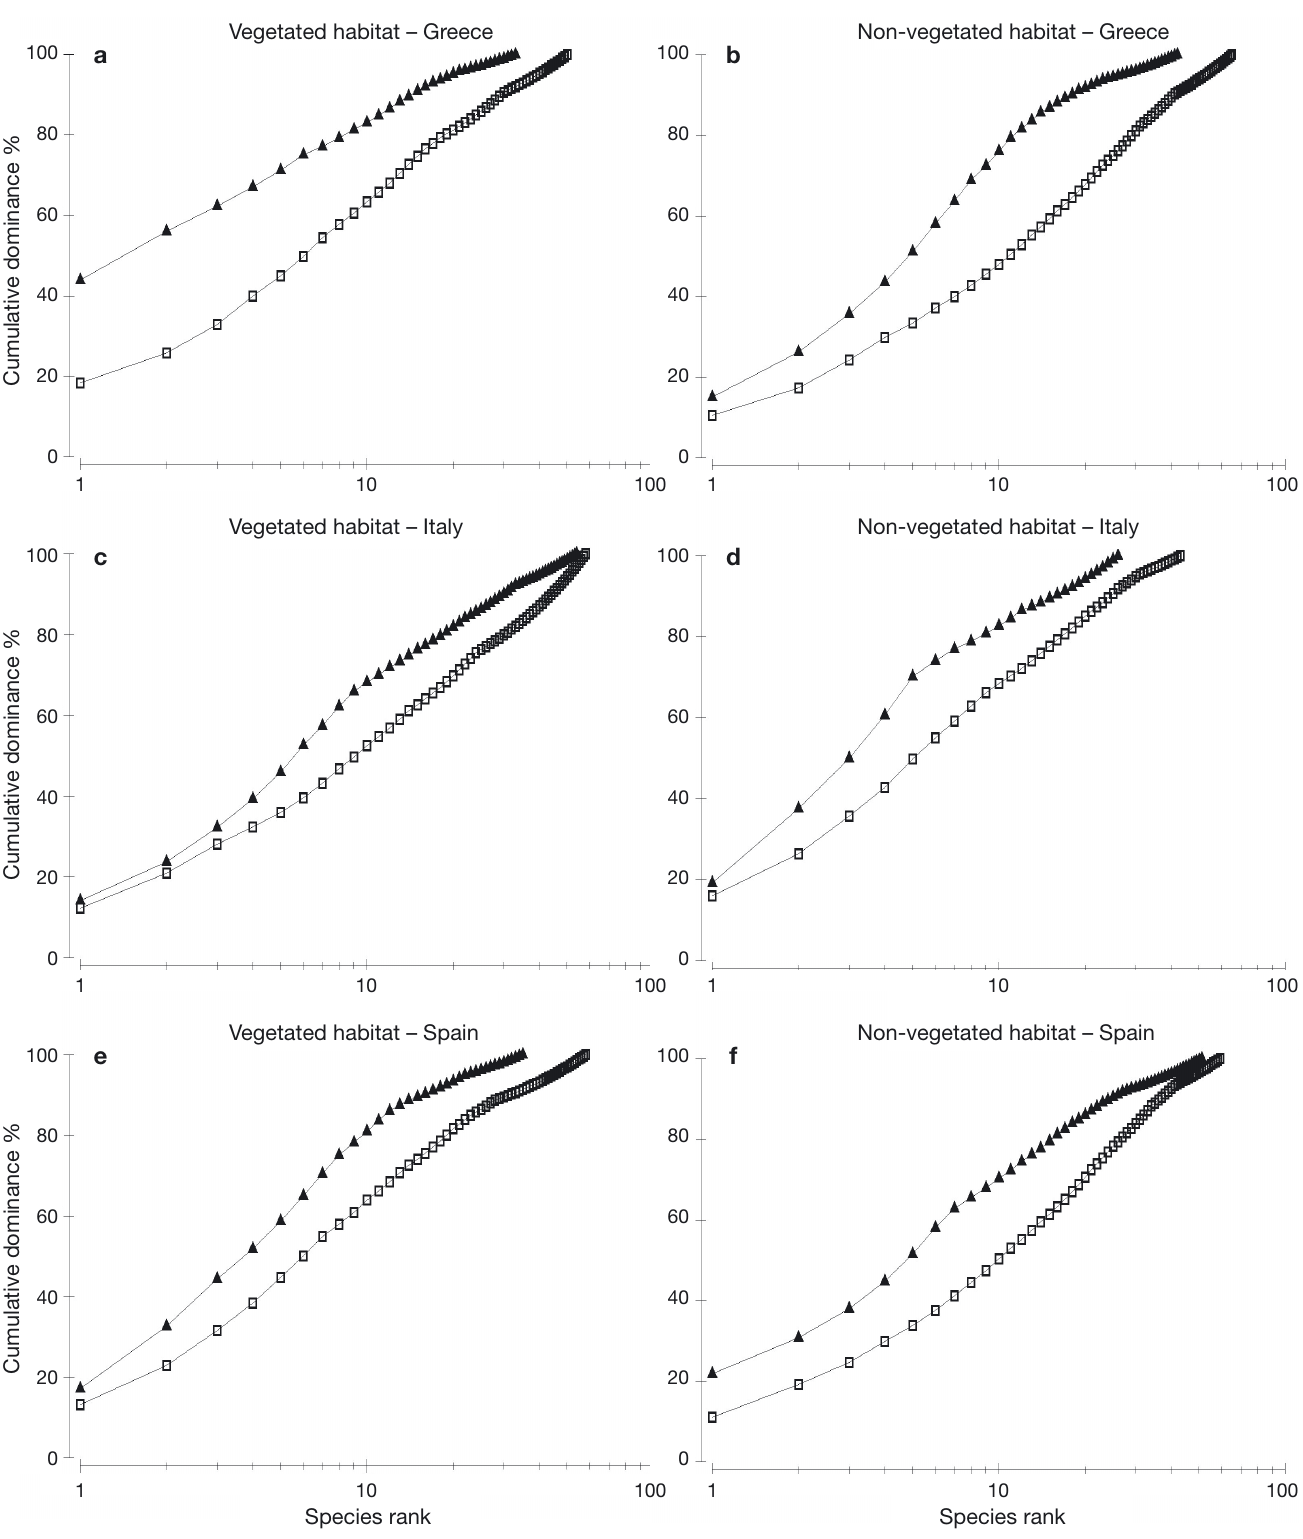
Fig. 3. K -dominance curves based on nematode species identified from the 3 investigated regions: (a) vegetated and (b) non- vegetated sediments in Greece, (c) vegetated and (d) non-vegetated sediments in Italy, and (e) vegetated and (f) non-vege- tated sediments in Spain. Each curve compares nematode structure in control ( h ) and impact ( m ) sites